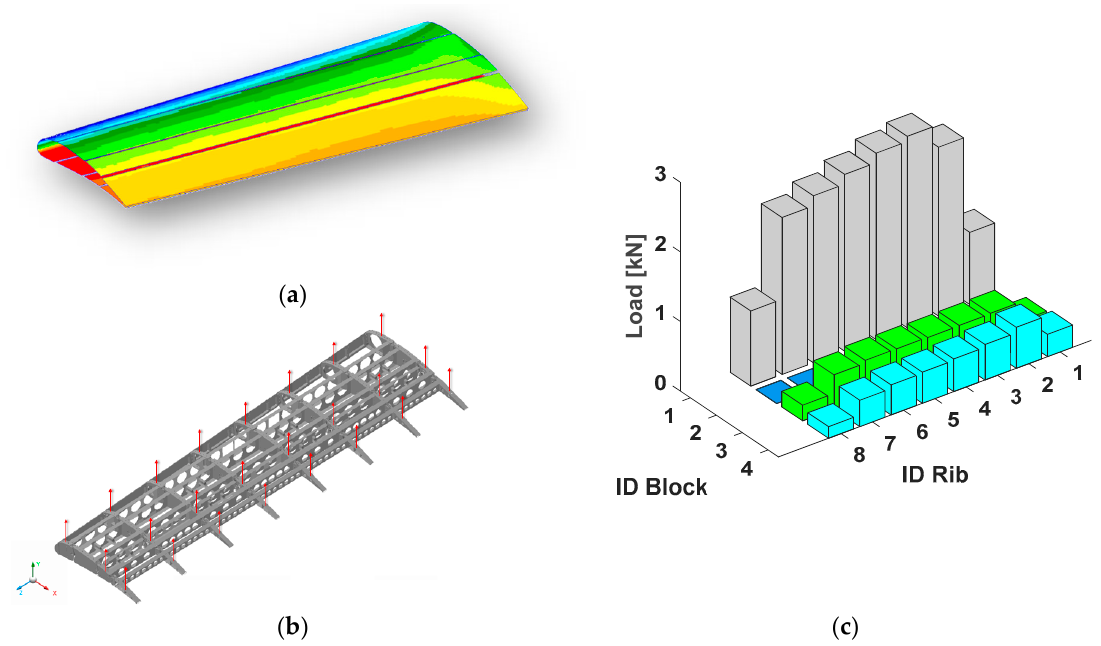
Figure 17. ( a ) pressure distribution at limit design condition; ( b ) lumped forces distribution along blocks B0, B2, B3 equivalent to the pressure distribution at limit design load condition; ( c ) histogram of the equivalent lumped forces distribution applied during tests (blocks B1, constrained).